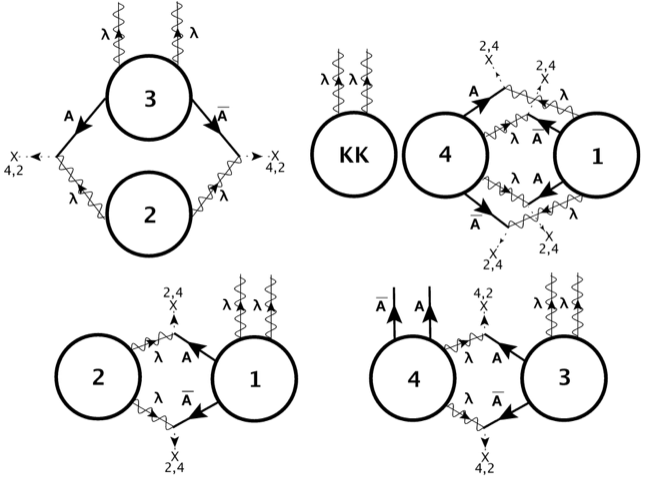
Figure 2: A sketch of the multi-monopole composites in the low-energy × SU ( 2 ) SU ( 3 ) theory. The antisymmetric VEVs are represented by a cross with a b their color indices. See text for